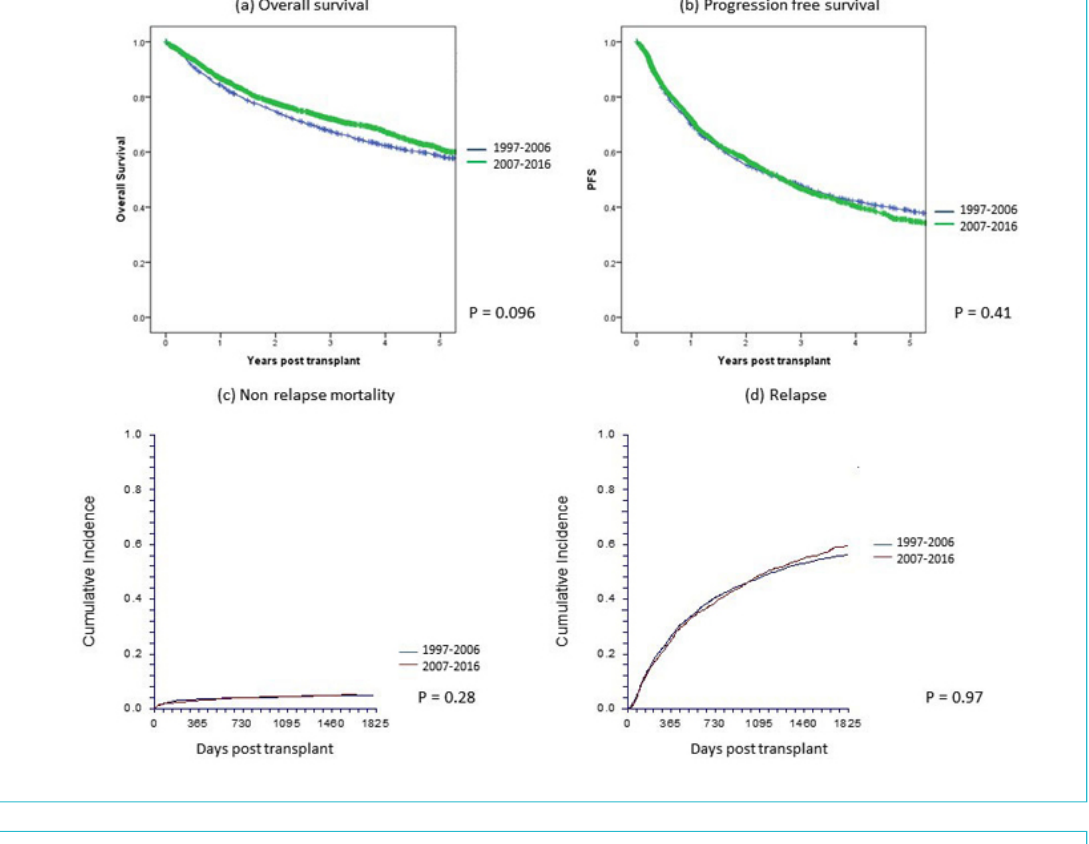
Figure 3: Main outcome by risk score of 2781 patients with allogeneic haematopoietic cell transplants by decade: (a) first decade 1997–2006, (b) second decade